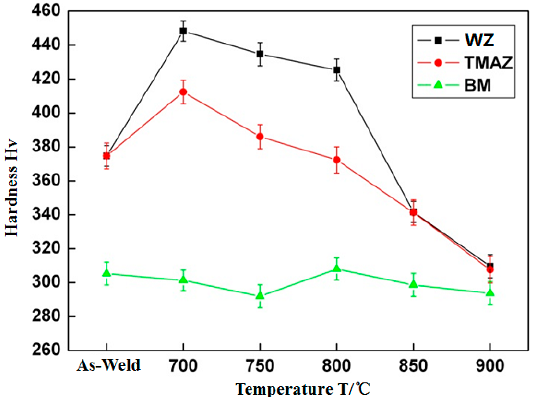
Figure 10. Microhardness of as-welded and heat-treated joints.